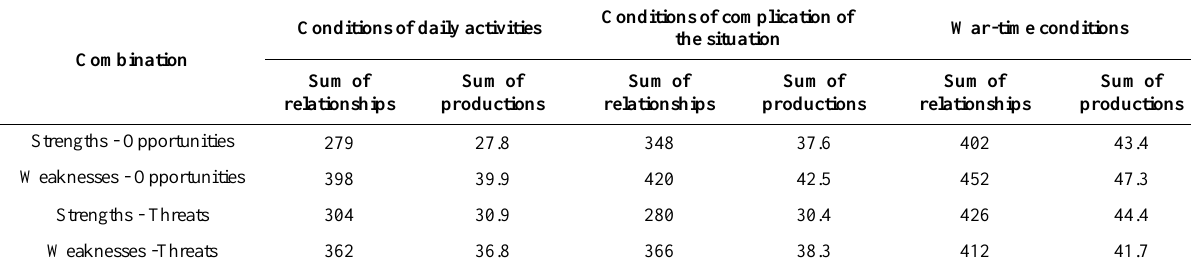
Table 6. Table of strengths and weaknesses, opportunities and